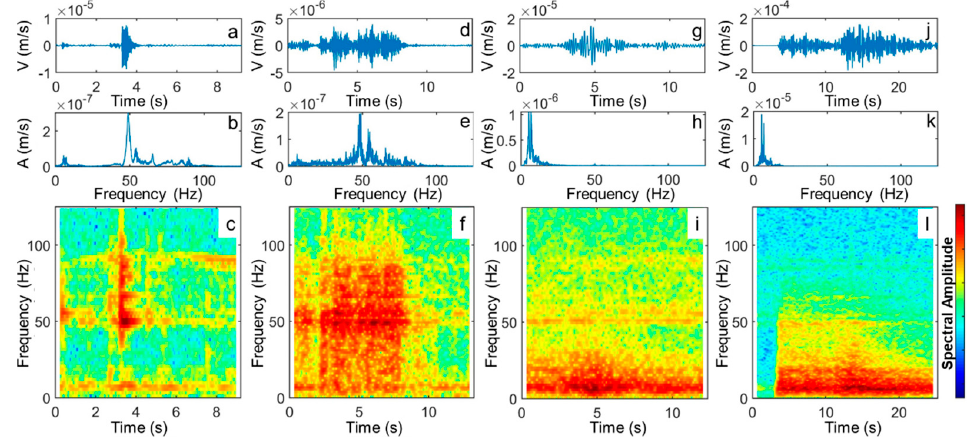
Figure 9. Example of seismic events representative of the four classes of signals generated by natural sources. ( a – c ): Microseismic events due to micro-fracturing processes (MS). ( d – f ): Long-lasting sequence of microseismic events (LONG-MS). ( g – i ): Low-frequency events possibly related to slip processes on pre-existing fracture surfaces. ( j – l ): earthquake (19 January 2020, 05:22:06.2, 44.72°N 8.1°E, depth=12 km, M L =3.1). In each column, from top to bottom: seismogram recorded on channel V2 (S2), amplitude spectrum and spectrogram.